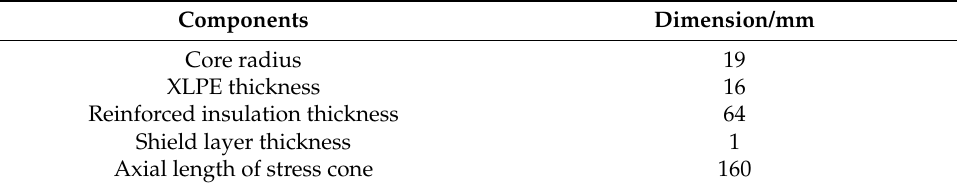
Figure 2. Geometry model of HVDC cable terminal: 1—conductive core; 2—inner shield; 3—XLPE main insulation; 4—silicone oil; 5—ceramic tube; 6—reinforce insulation; 7—stress cone; 8—outer shield. a—stress cone front terminal; b—stress cone root; c,d—stress cone interface; e—common point of main insulation, silicone oil and reinforce insulation; f—cable outer shield. Table 1. Dimensions of individual components in cable